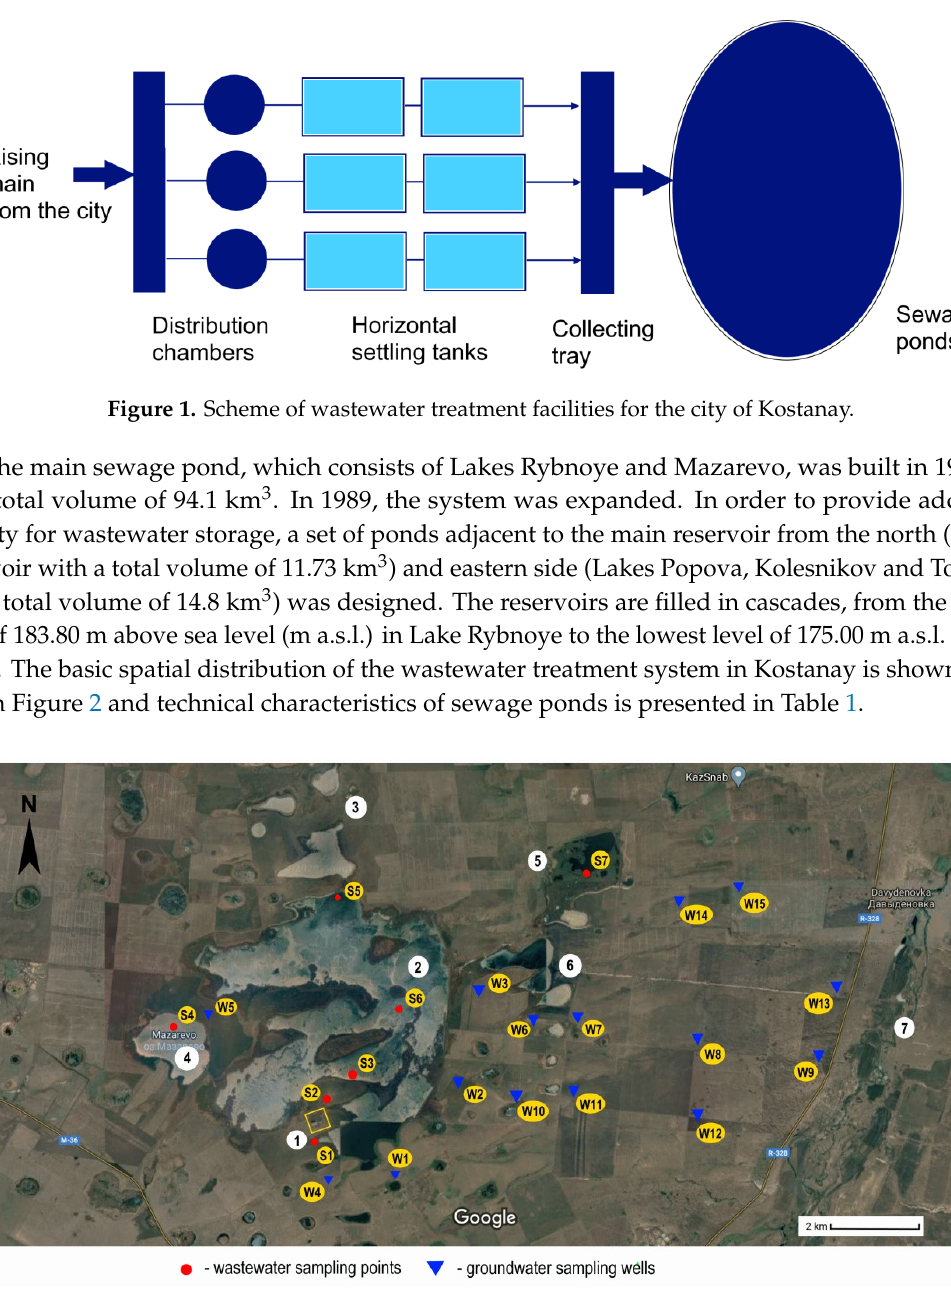
Figure 2. Arrangement of sewage treatment facilities and sewage, groundwater and soil sampling points used for the research. ( 1 ) Mechanical pretreatment units; ( 2 ) Rybnoye Lake; ( 3 ) Kurgan Lake; ( 4 ) Mazarevo Lake; ( 5 ) Popov Lake; ( 6 ) Kolesnikov and Tomarkol Lake; ( 7 ) Tobol River; (S1–S7) wastewater sampling points; (W1–W15) groundwater sampling wells; (B1–B10) soil sampling boreholes.